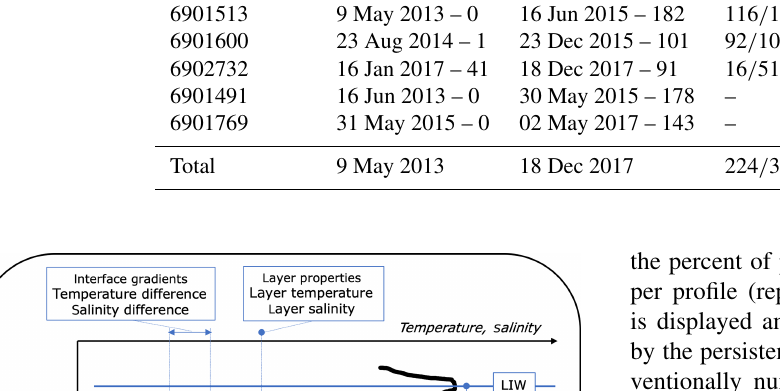
Table 1. Selection of CTD profiles collected by five floats in the Algerian Basin and in the Tyrrhenian Sea. Each deployment is labeled using the World Meteorological Organization (WMO) float number. Left columns: date and cycle number of the first and the last profiles of this selection. Right columns: number of profiles with staircase detection/total number of profiles (fraction of profiles with staircase detection). WMO float no.